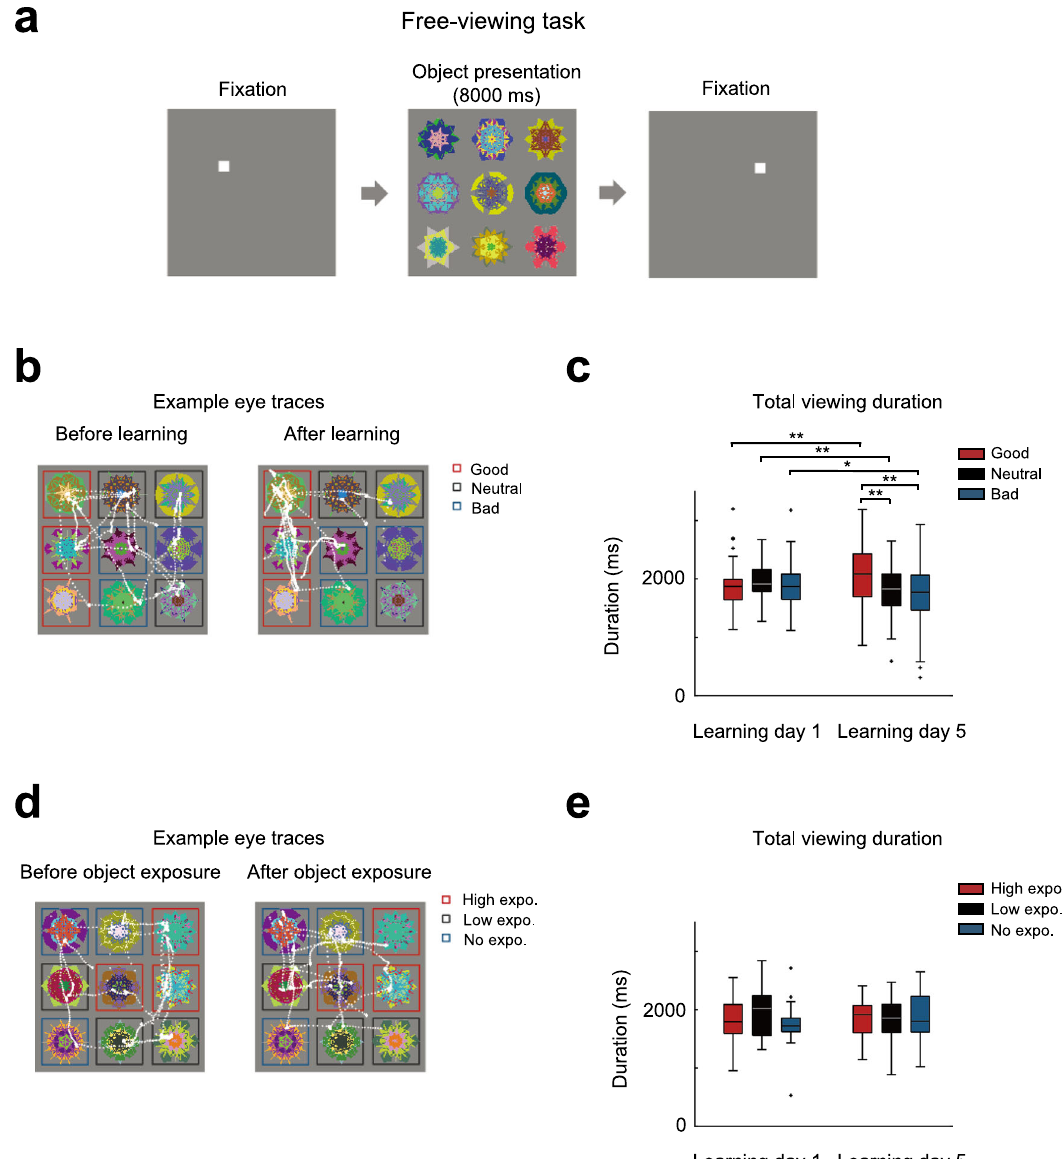
Fig. 2 Free-viewing task in human subjects. a During each trial of the free-viewing task, a fi xation square was followed by the nine objects (three good, three neutral, and three bad objects) presented without any feedback. The participants were instructed freely to observe the nine objects without any feedback. b Example eye traces during the free-viewing task before (left) and after (right) object-value learning (learning days 1 and 5). The eye position is depicted by the white dot (2 ms/dots). c Boxplots for the total viewing duration for good, neutral, or bad objects during the free-viewing task on learning days 1 and 5. d Example eye traces during the free-viewing task before (left) and after (right) exposure to the objects from the control set. e Boxplots for the total viewing duration for high-exposure, low-exposure, or no-exposure objects during the free-viewing task for the control set objects. In c and e , the middle line indicates the median, and the bottom and the top of the box correspond to the 25th and 75th percentiles, respectively. The upper and lower whiskers extend to the highest and lowest values that are within 1.5 times interquartile range of the hinge. Outlying data beyond this are plotted as dots ( n = 26 participants, two-tailed paired t tests, * p < 0.05, ** p <